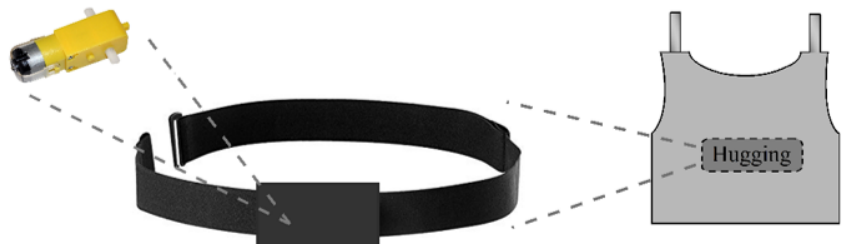
Figure 4. Location of the strap and actuator for the hugging affection